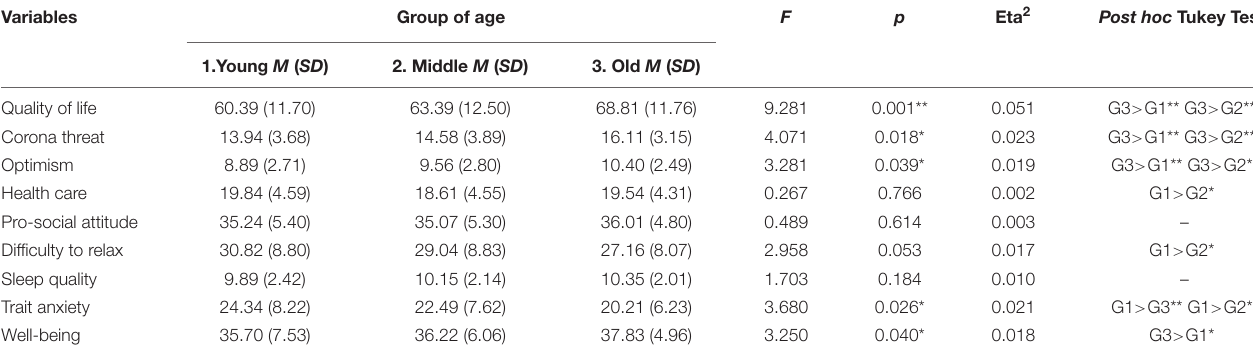
TABLE 4 | Differences in group of